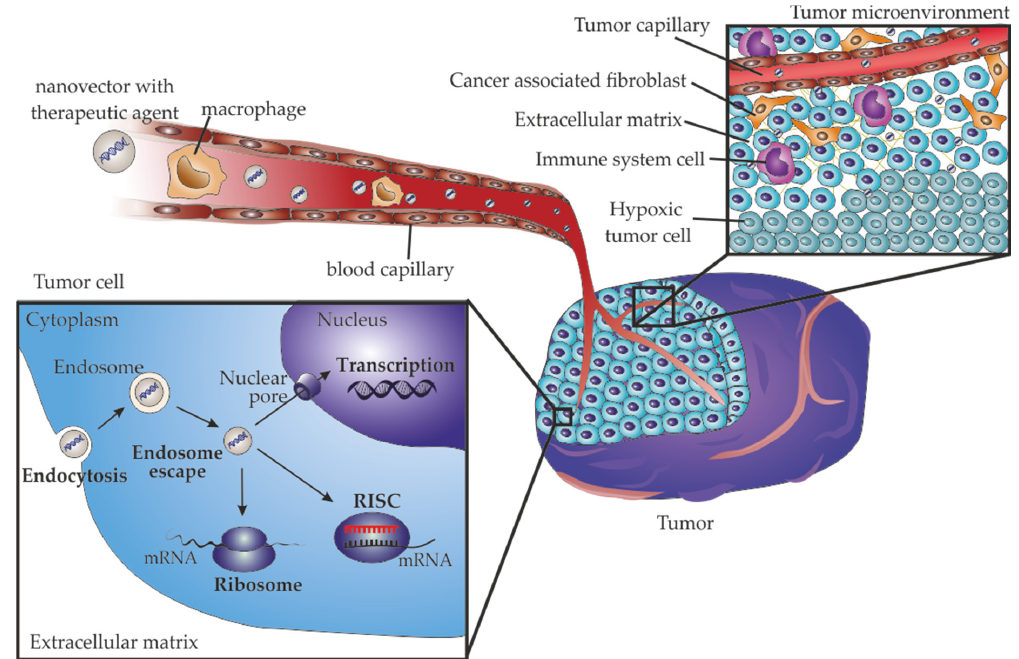
Figure 2. Barriers that nanoparticles must overcome for effective cancer gene delivery. In a systemic administration, nanoparticles should travel through the blood circulatory system, avoiding the immune